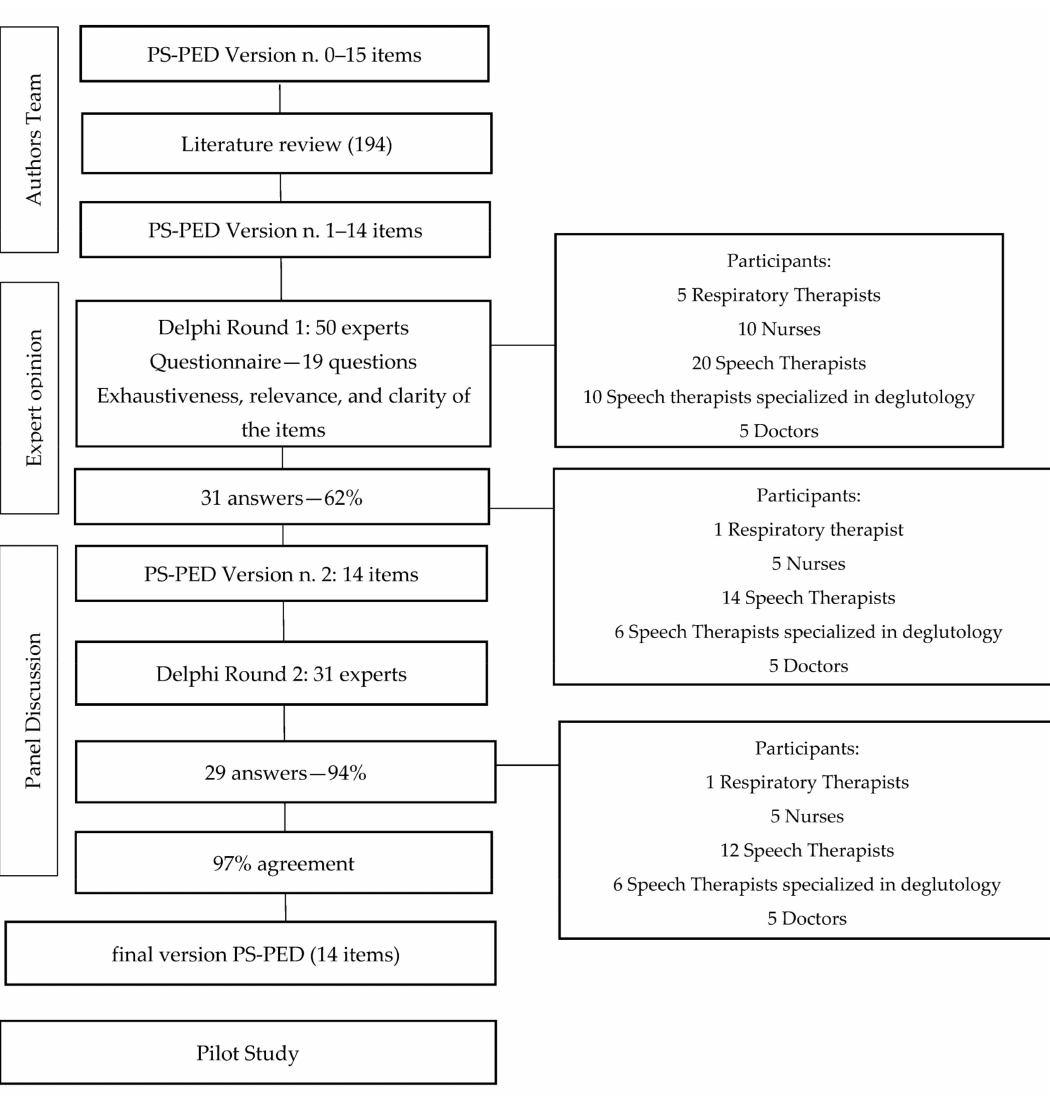
Figure 2. Reports each step for the development of